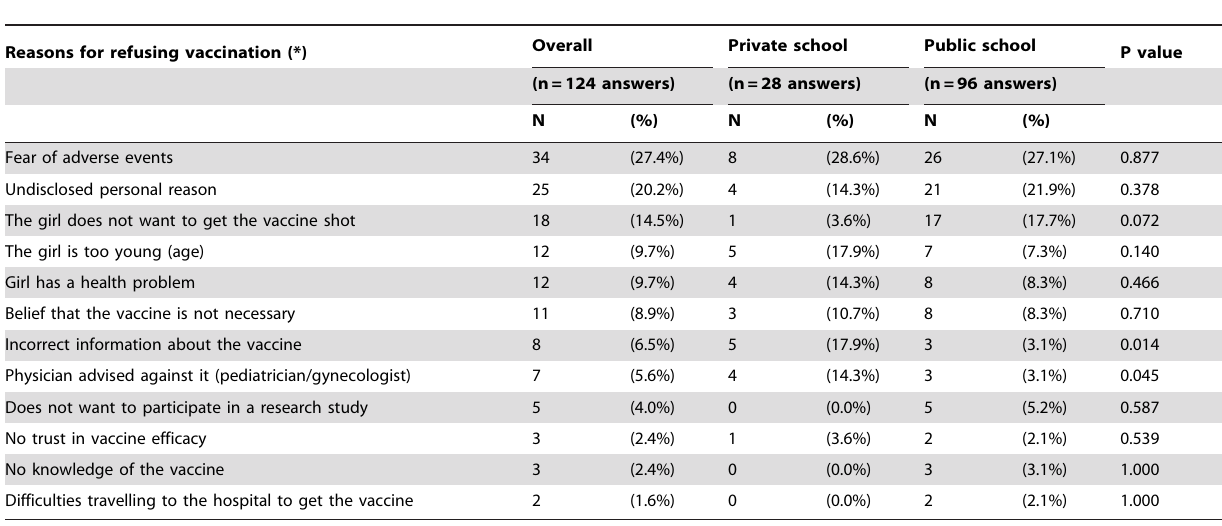
Table 3. Reasons given by the parents and guardians for refusing to participate in the vaccination program.